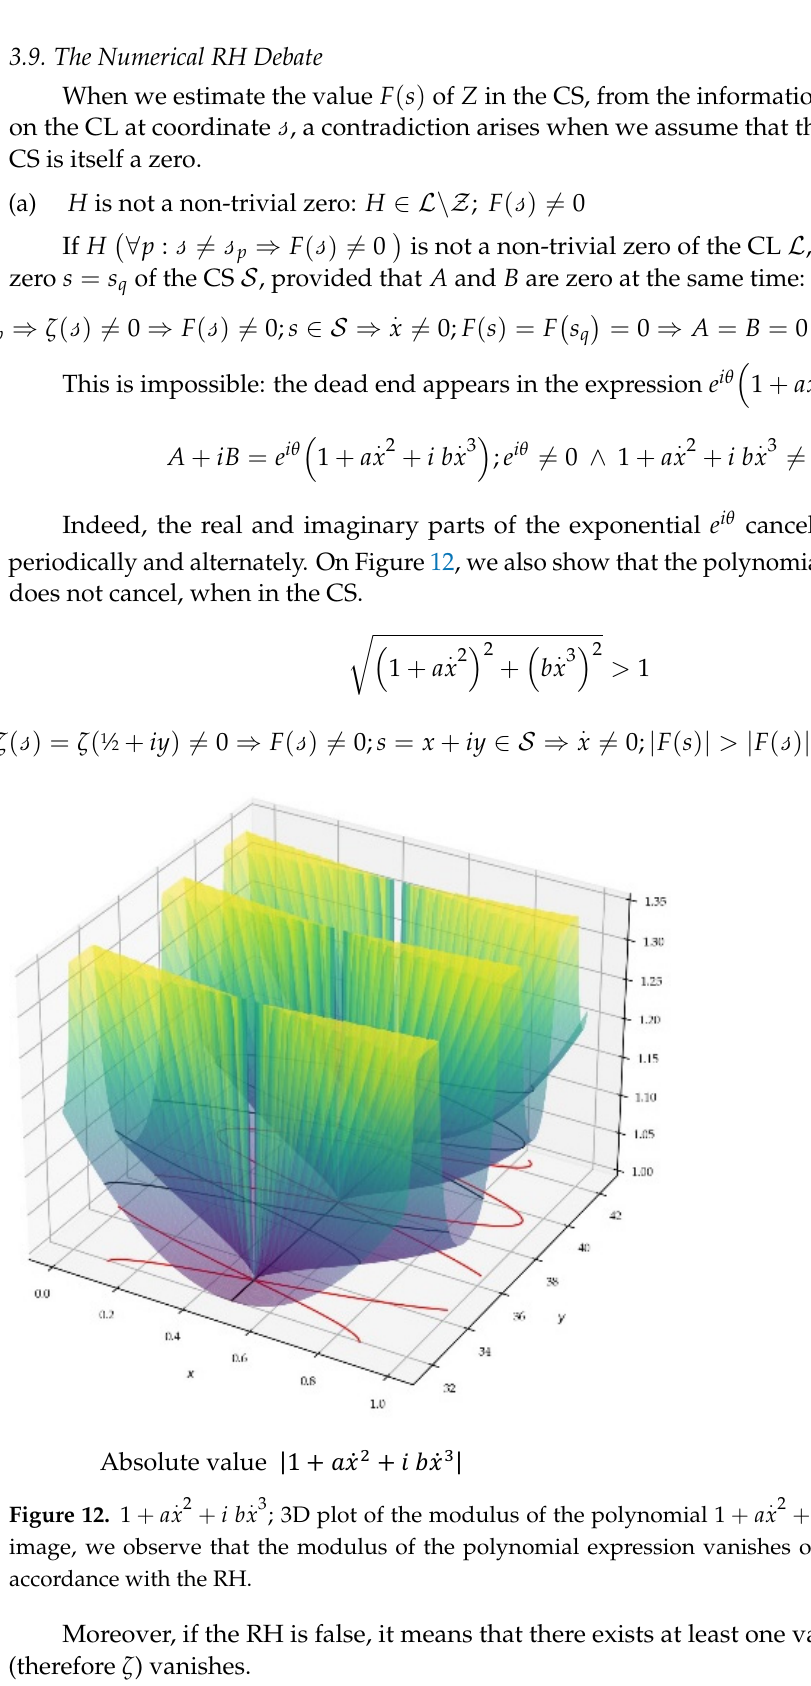
Figure 12. 1 + 𝑎𝑥(cid:4662) (cid:2870) + 𝑖 𝑏𝑥(cid:4662) (cid:2871) ; 3D plot of the modulus of the polynomial 1 + 𝑎𝑥(cid:4662) (cid:2870) + 𝑖 𝑏𝑥(cid:4662) (cid:2871) . On this 3D image, we observe that the modulus of the polynomial expression vanishes only on the CL, in accordance with the RH.